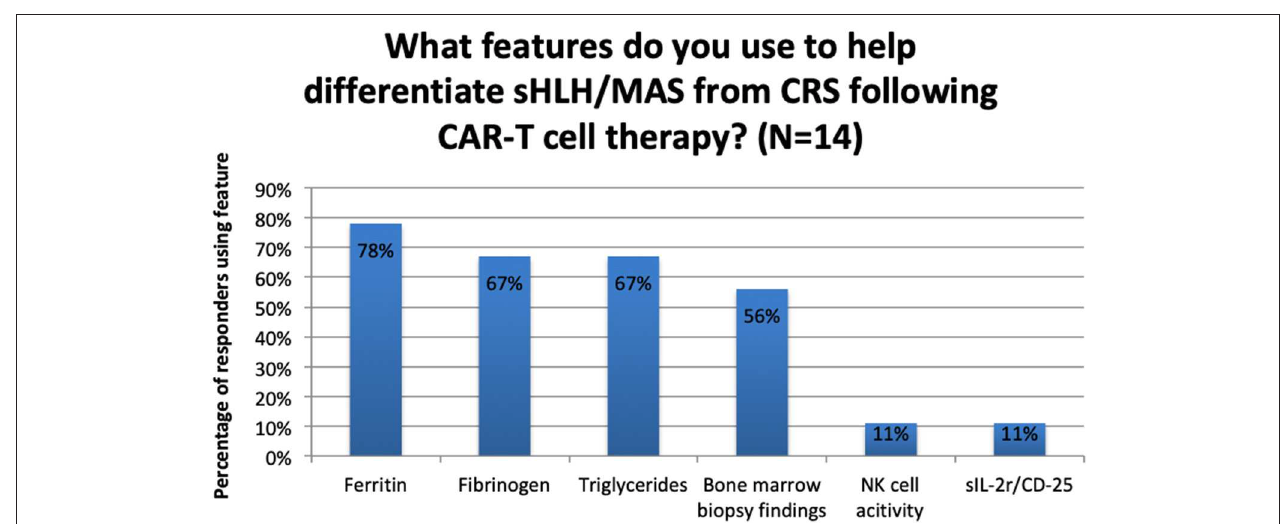
FIGURE 2 | Use of laboratory features to differentiate between sHLH/MAS and CRS following CAR-T cell therapy.